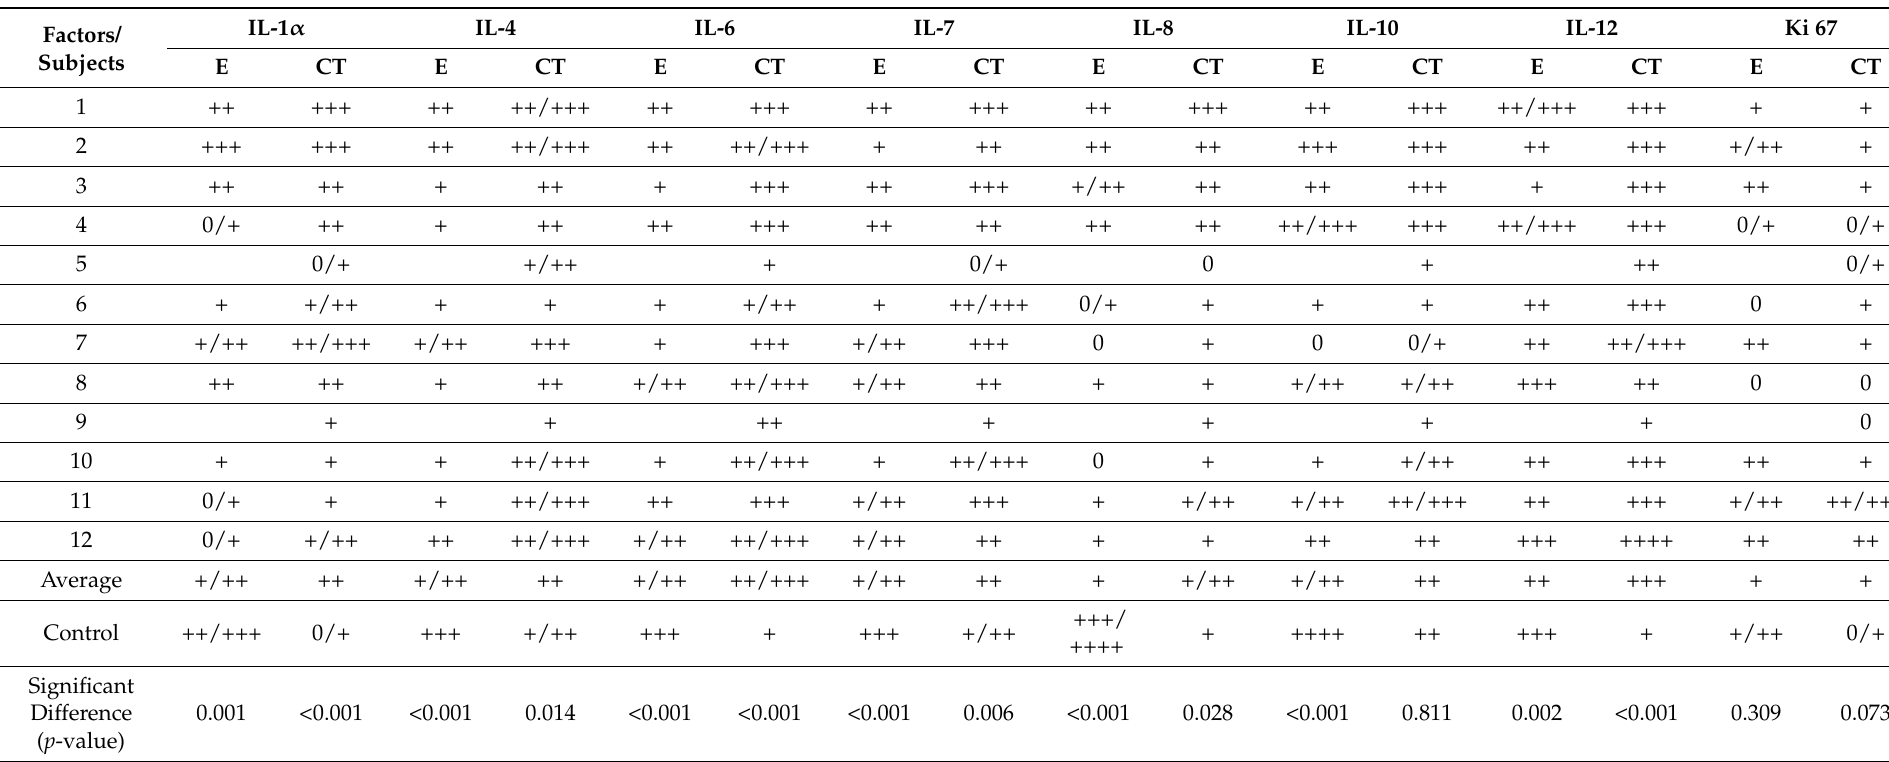
Table 1. Cytokines and proliferation marker Ki67 positive structures in samples of nasal polyps and significant differences between them and the control